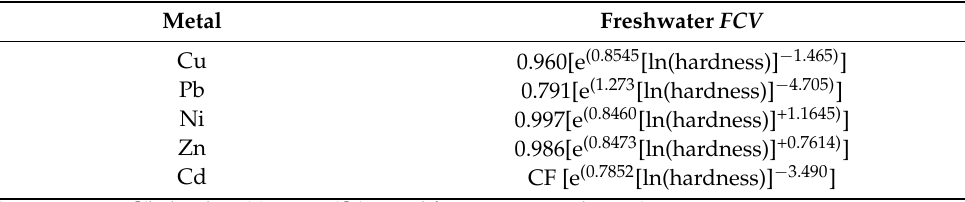
Table 1. Derived final chronic values from dissolved water concentrations.